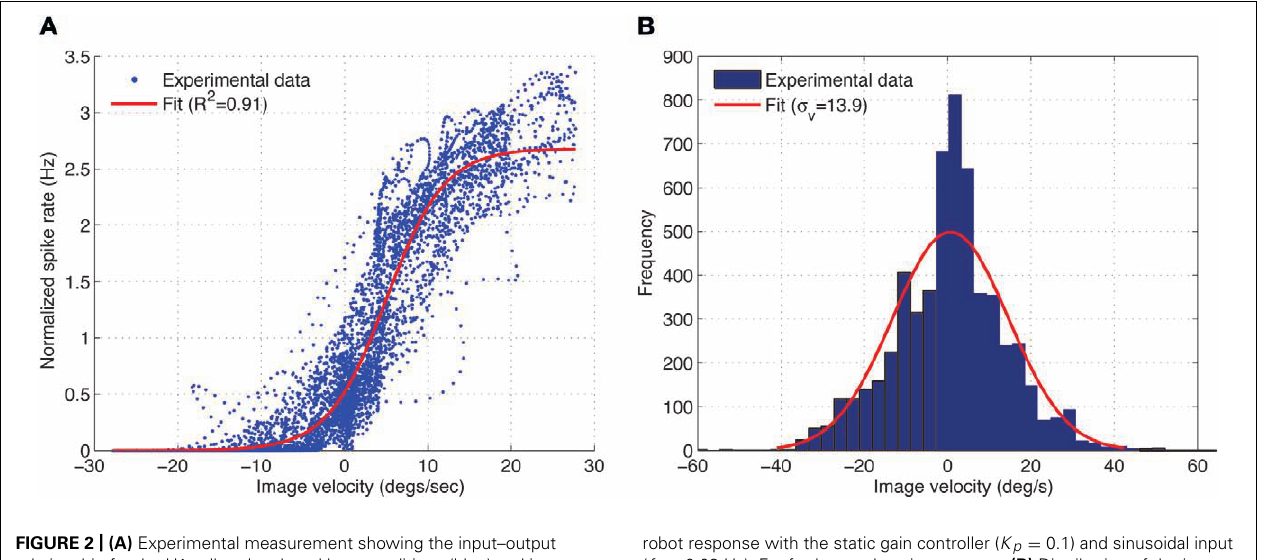
robot response with the static gain controller ( K p = 0.1) and sinusoidal input ( f i = 0.03 Hz). For further explanation see text. (B) Distribution of the image velocities observed in closed-loop is approximately